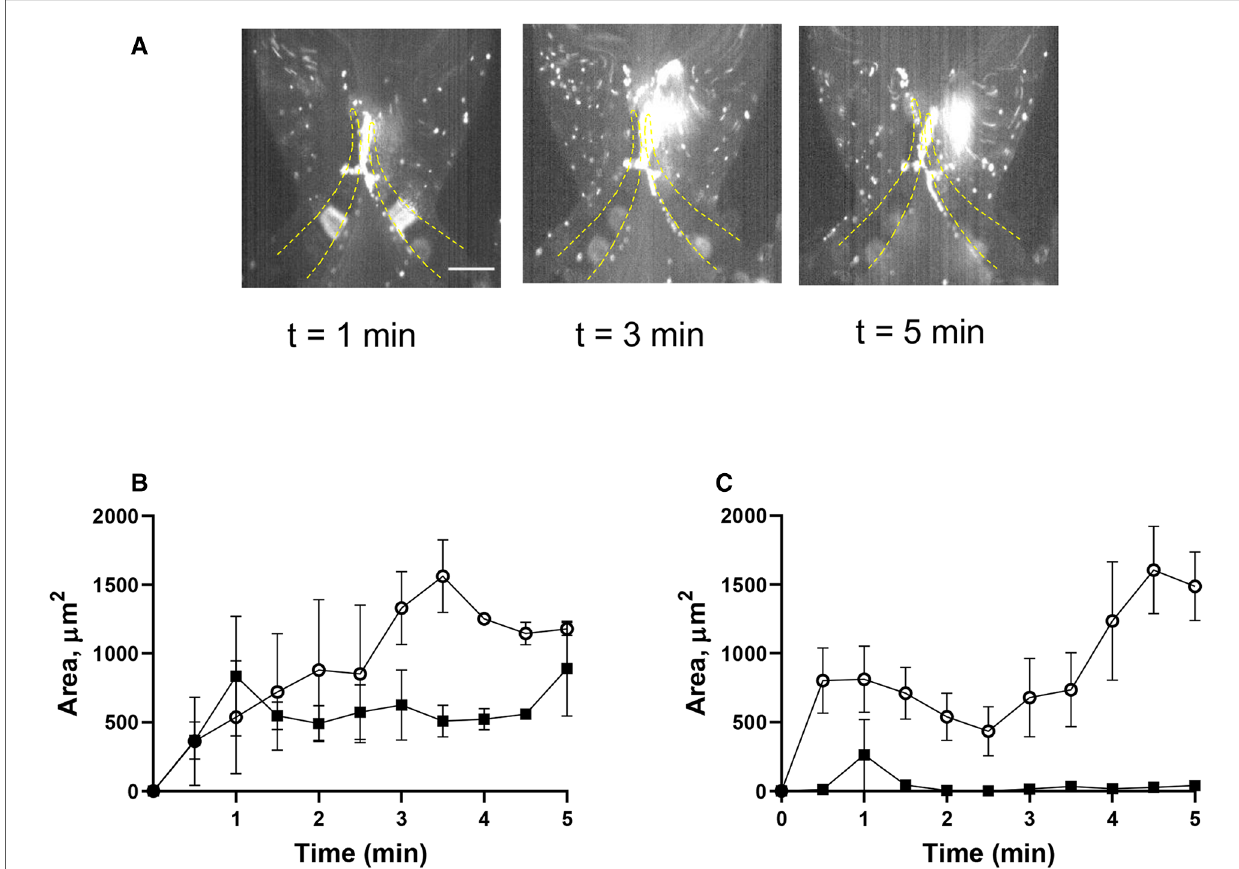
FIGURE 5 Histamine increases platelet deposition in the valve pockets (TS area). ( A ) HUVECs inside the chamber were incubated with histamine (10 µM, 15 min), and whole blood reconstituted with resting platelets was perfused through a symmetrical valve for 5 min. ( B,C ) quantitation of platelet accumulation on more fl exible (circles) and less fl exible (squares) lea fl ets, TL and TS region, respectively. Scale bar 100 µm. Error bars represent SEM, n